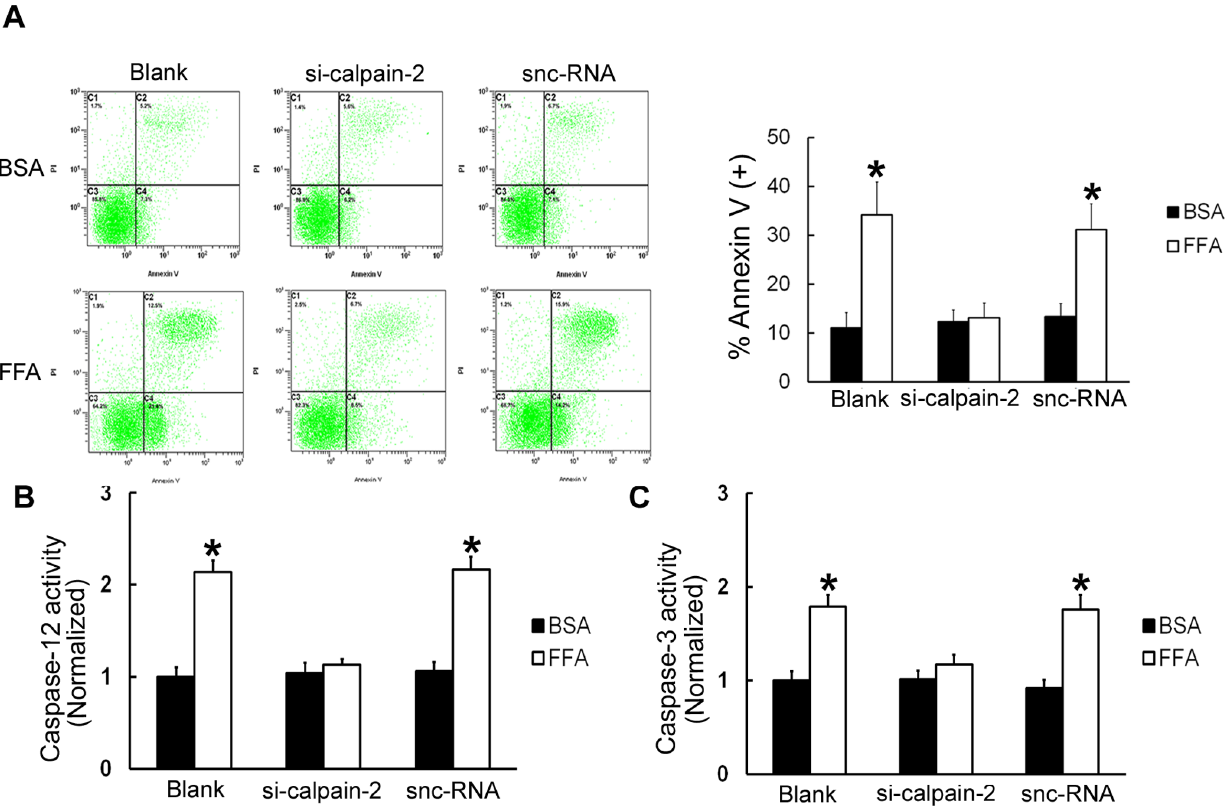
Figure 4. Calpain-2 is required for FFA treatment-induced b -TC3 cell apoptosis. The cells were treated with calpain-2 siRNA, incubated for 24 h, and then stimulated with FFA or BSA for 16 h. (A) Cell death was quantified by annexin V/PI double staining. (B) Caspase-12 activity was detected after cells were treated with calpain-2 siRNA. (C) Caspase-3 activity was detected after cells were treated with calpain-2 siRNA. snc-RNA- treated cells were used as a negative control. Bars represent each sample performed in triplicate, and the error bars represent the standard deviations. * P , 0.05, by one-way ANOVA.